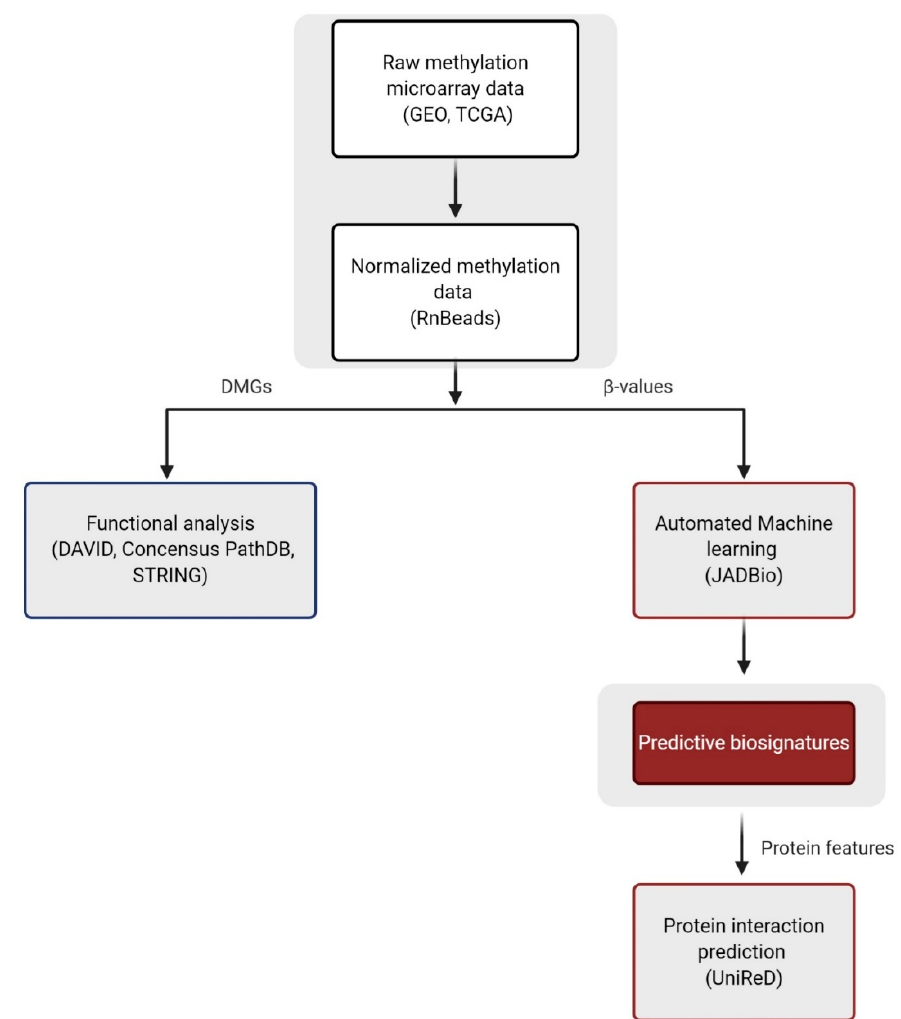
Figure 1. Study workflow. Abbreviations: DMGs = differentially methylated genes, GEO = Gene Expression Omnibus, TCGA = The Cancer Genome Atlas. Created with BioRender.com, accessed on 8 February 2021.